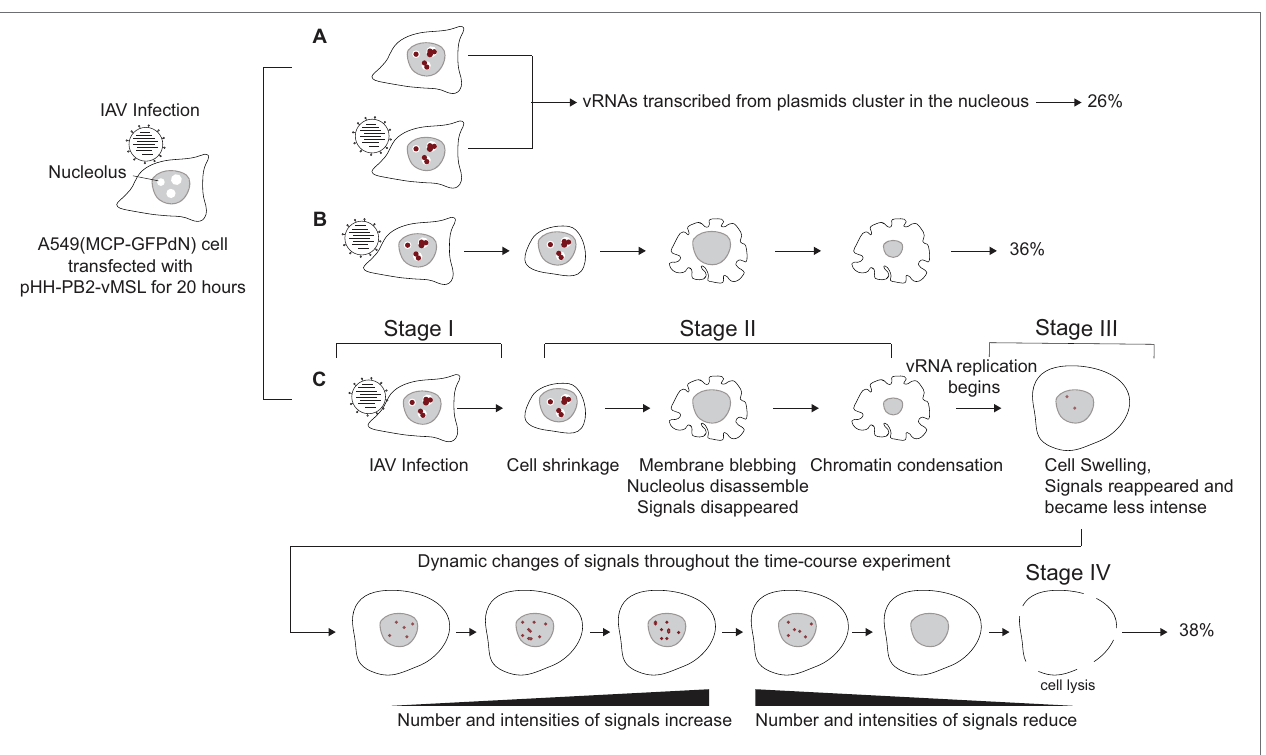
FIGURE 6 | Timing of IAV-induced apoptosis and PB2-vMSL vRNA replication. A549(MCP-GFPdN) cells transfected with pHH-PB2-vMSL were infected by IAV and then imaged for 18 h. The images revealed three types of cells with punctate signals: (A) non-apoptotic cells; (B) cells that underwent apoptosis but failed to support PB2-vMSL vRNA replication; and (C) cells that initiated apoptosis and also supported PB2-vMSL vRNA replication. The results also showed that PB2-vMSL vRNA replication occurred soon after membrane blebbing and chromatin